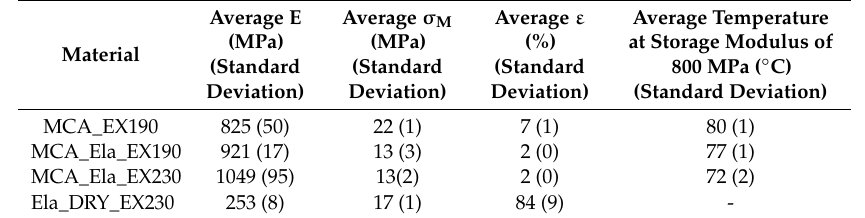
Table 1. Average values of Young’s Modulus (E), maximum stress ( σ M ), and strain at break ( ε ) from tensile tests and average temperature corresponding to 800 MPa of storage modulus from